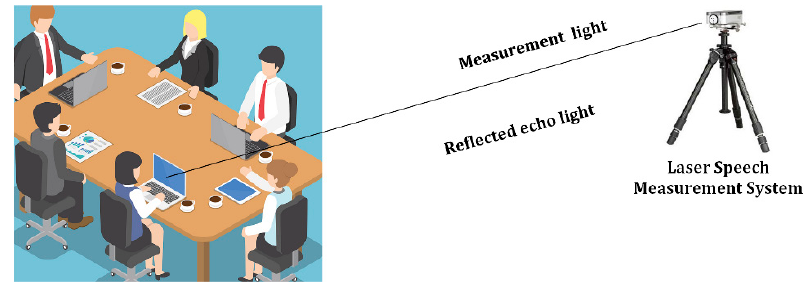
Figure 2. Real example of detection by a laser speech measurement system.